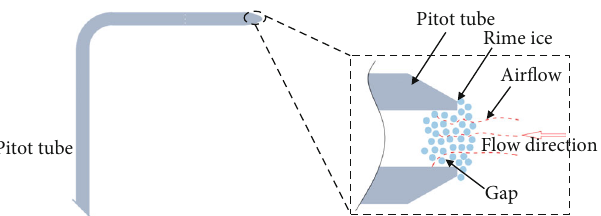
Figure 12: Rime ice blocking the total pressure hole of the pitot tube.